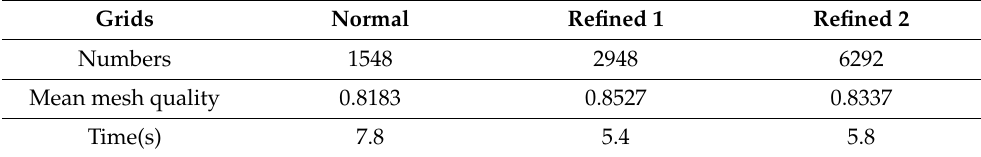
Table 4. Independence of the freezing time of the water droplet at 243.15 K. Grids